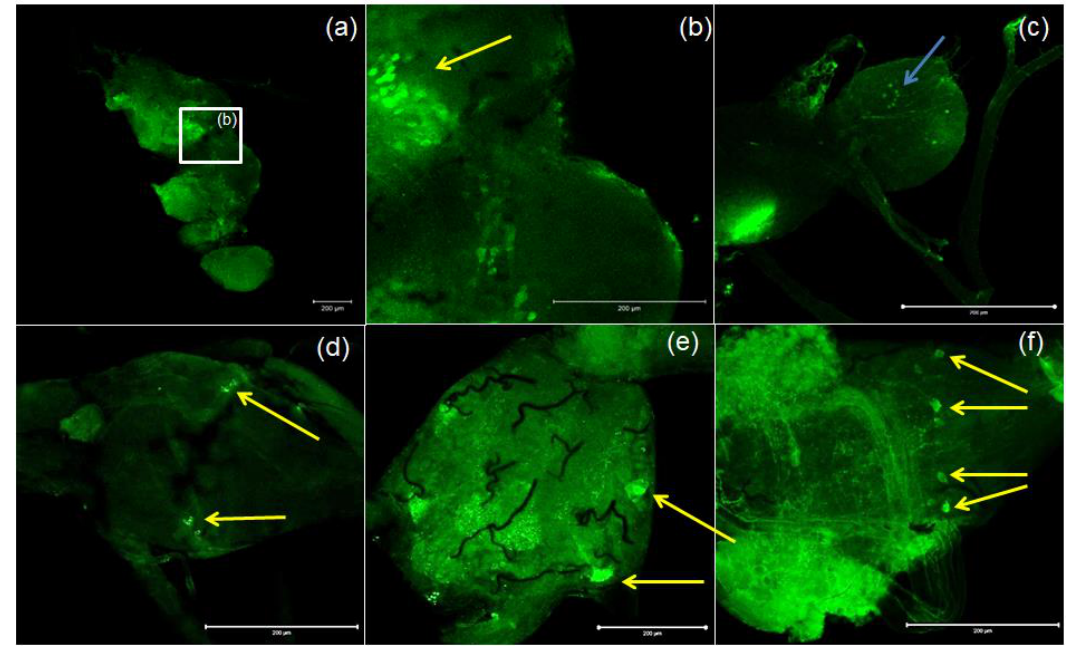
Figure 4. Examples of images from confocal microscopy depicting the location of PISCF/AST-reactive neurons in the brain ( a , b ) and CC/CA ( c ) of adult as well as the VNC of the larvae ( d ), pupae ( e ) and adults ( f ) of T. molitor beetle using antibodies against Manse-PISCF. The selected scale is 200 μm. The yellow arrows indicate the nerve cell bodies, and the blue arrows show signals present in the CA. CC/CA— corpus cardiacum/corpus allatum , VNC—ventral nerve cord.